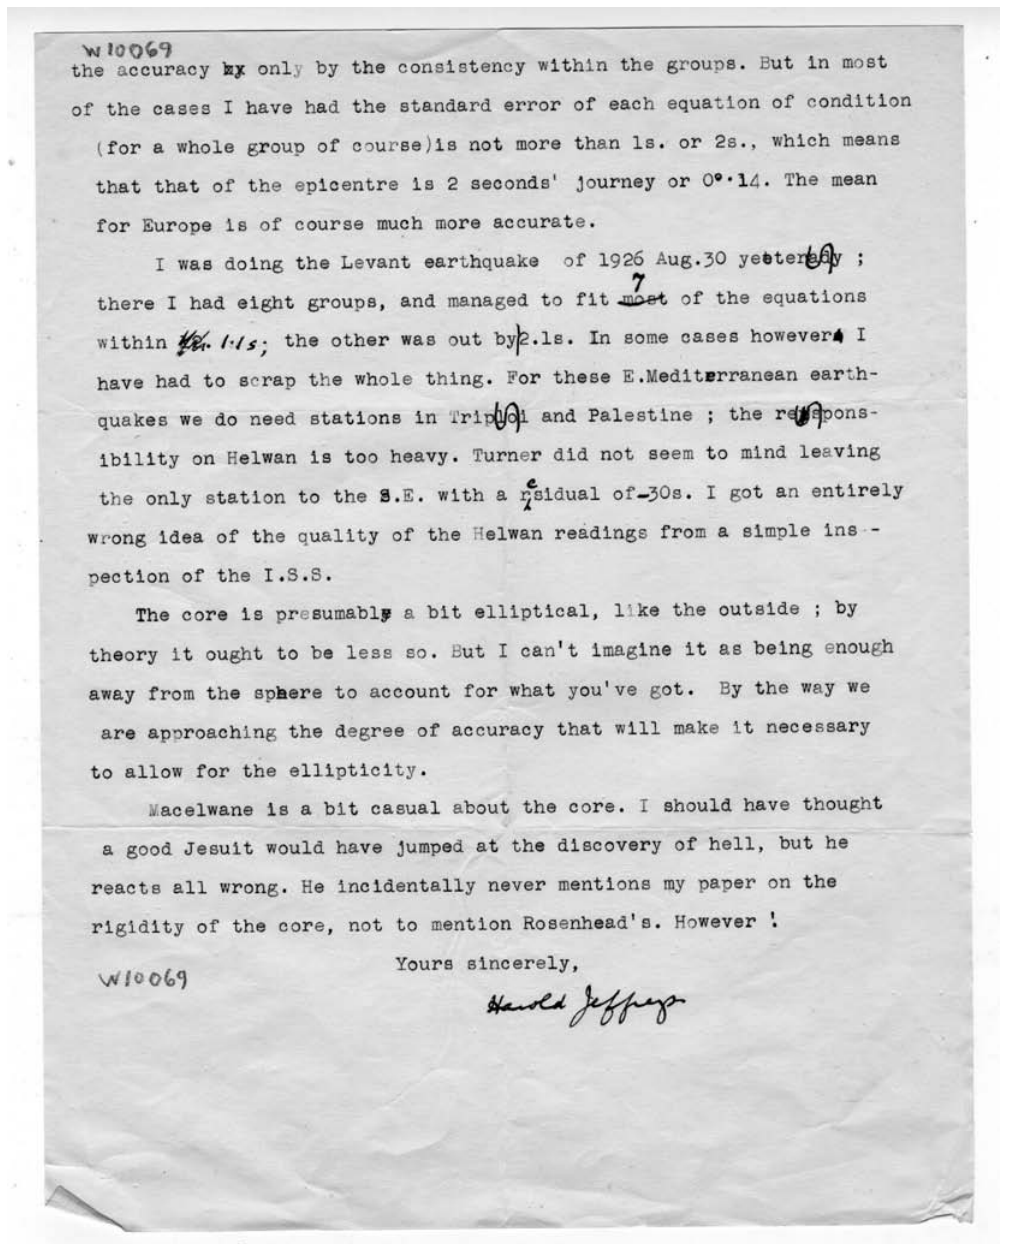
Fig. 5. Second page of Jeffreys’ 1932 June 1 letter. The main subject is epicentre determinations, by the group method, but in the last paragraph the inner core discontinuity surface is discussed: «Macelwane is a bit casual about the core. I should have thought a good Jesuit would have jumped at the discovery of hell, but he reacts all